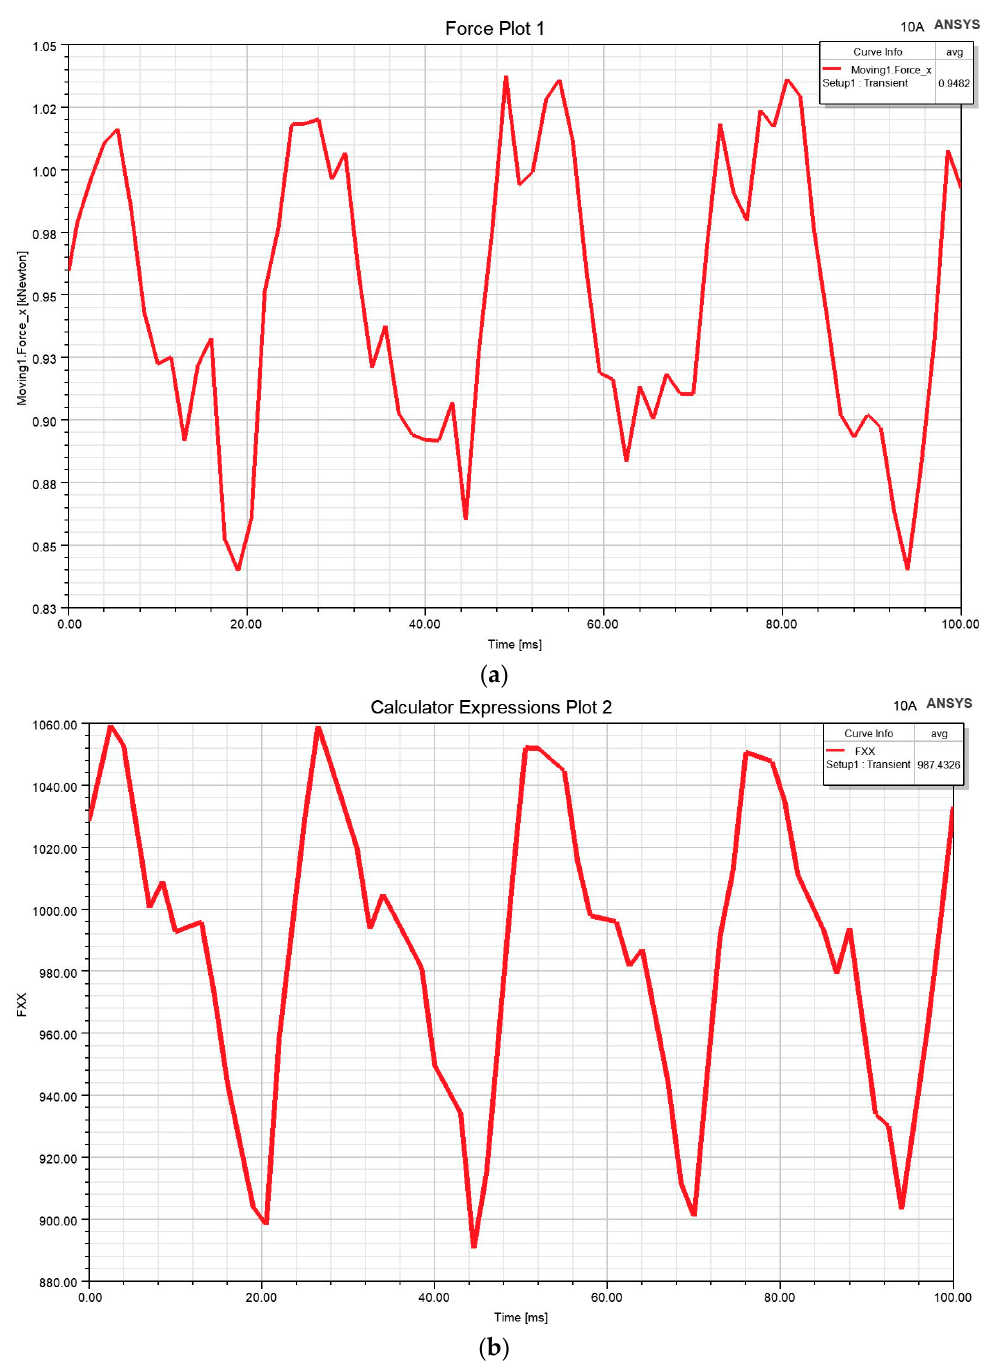
Figure 12. Maxwell stress tensor method and finite element method solution for the horizontal electromagnetic thrust of the motor: ( a ) Finite element solves for the horizontal electromagnetic thrust of the motor; ( b ) Maxwell stress tensor method solves for the horizontal electromagnetic thrust of the motor.